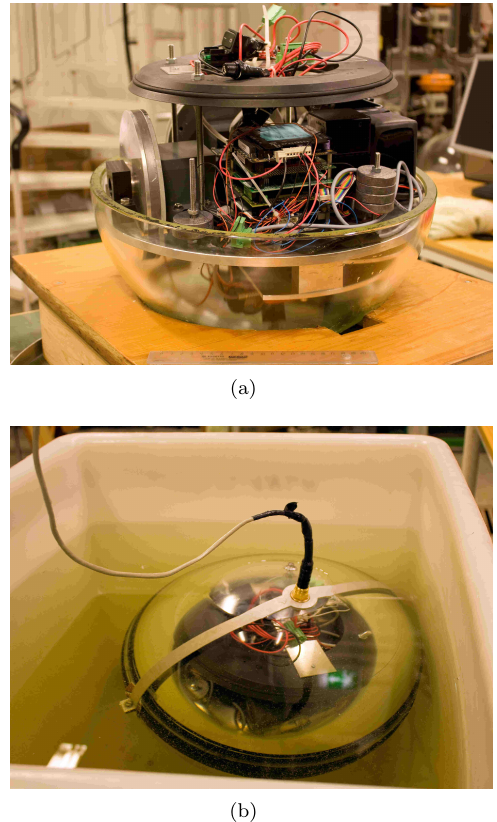
Figure 2: AUVSAT. (a) shows when the top sphere is detached to expose the inner construction and (b) shows the submerged satellite during experiments.